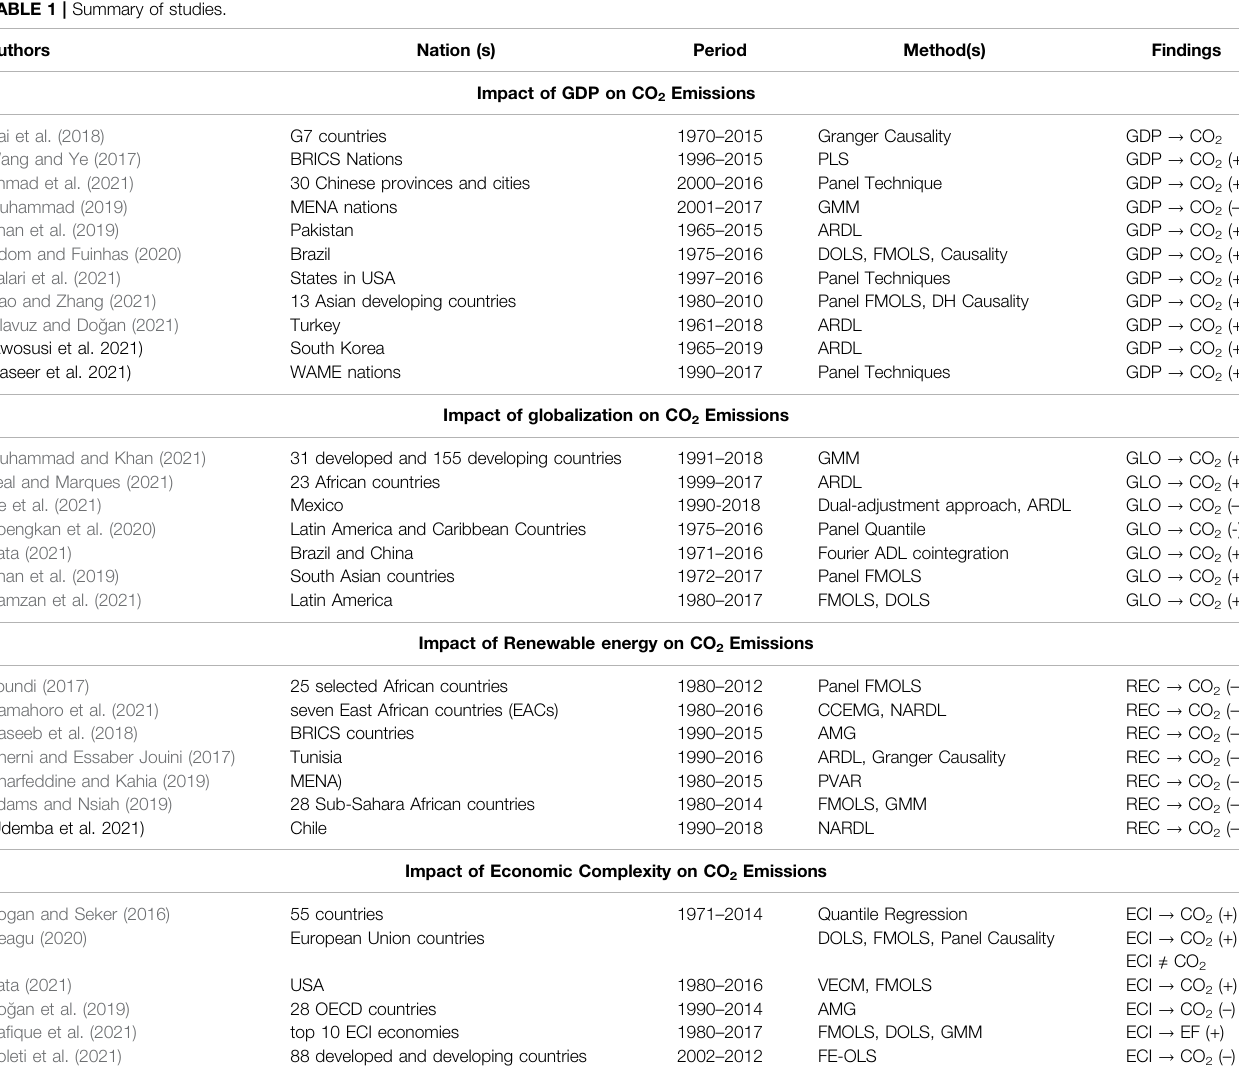
TABLE 1 | Summary of